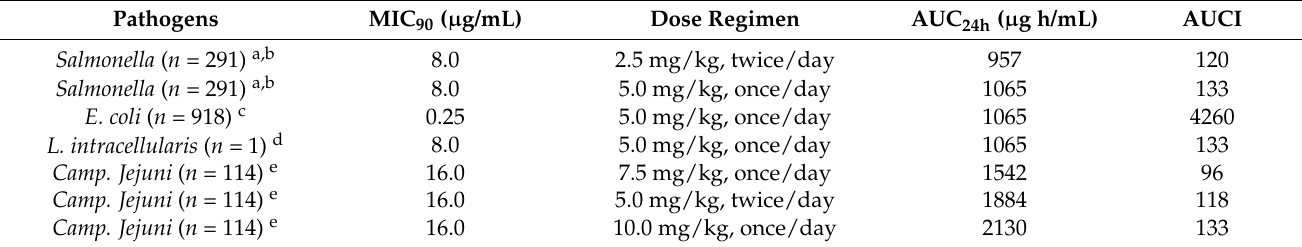
Table 3. The potential dose regimen of ENR-SD granules against common intestine bacterial in pigs. Pathogens MIC 90 ( µ g/mL) Dose Regimen AUC 24h ( µ g h/mL) AUCI Salmonella ( n = 291) a,b 8.0